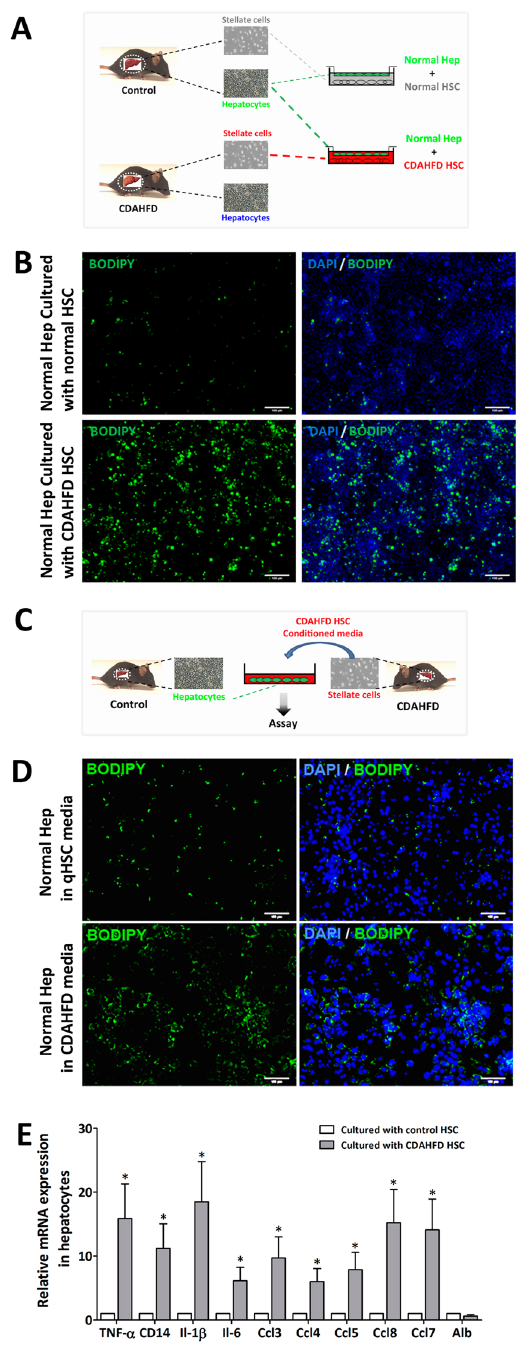
Figure 3. Hepatic stellate cells isolated from mice with steatohepatitis induce steatosis and inflammation in cocultured hepatocytes. ( A ) Diagram of the experiment showing coculture of healthy hepatocytes with hepatic stellate cells from either control mice or from mice with CDAHFD induced steatohepatitis. ( B ) Top row: Healthy hepatocytes cocultured with HSCs from control mice showed very few lipid droplets stained with Bodipy. Bottom row: Initially healthy hepatocytes cocultured with HSCs from mice with CDAHFD induced steatohepatitis developed significantly more lipid droplets. ( C ) Induction of fatty accumulation in hepatocytes can be achieved when the conditioned media from HSCs from mice with CDAHFD induced steatohepatitis is applied to healthy hepatocytes. ( D ) Top row: When quiescent HSC conditioned media was applied to healthy hepatocytes, steatosis was not induced. Bottom row: Conditioned media of HSCs from mice with CDAHFD induced steatohepatitis induced steatosis in initially healthy hepatocytes. Lipid droplets stained with Bodipy. ( E ) Initially healthy hepatocytes cocultured with HSCs from mice with CDAHFD induced steatohepatitis expressed higher levels of several inflammatory cytokines and chemoattractants than when they were cocultured with control HSCs, measured with qPCR. Data are presented as mean + / − SD ( * P < 0.05). NASH, non-alcoholic steatohepatitis; CDAHFD, choline-deficient L-amino acid defined high fat diet; Hep, hepatocyte; HSC, hepatic stellate